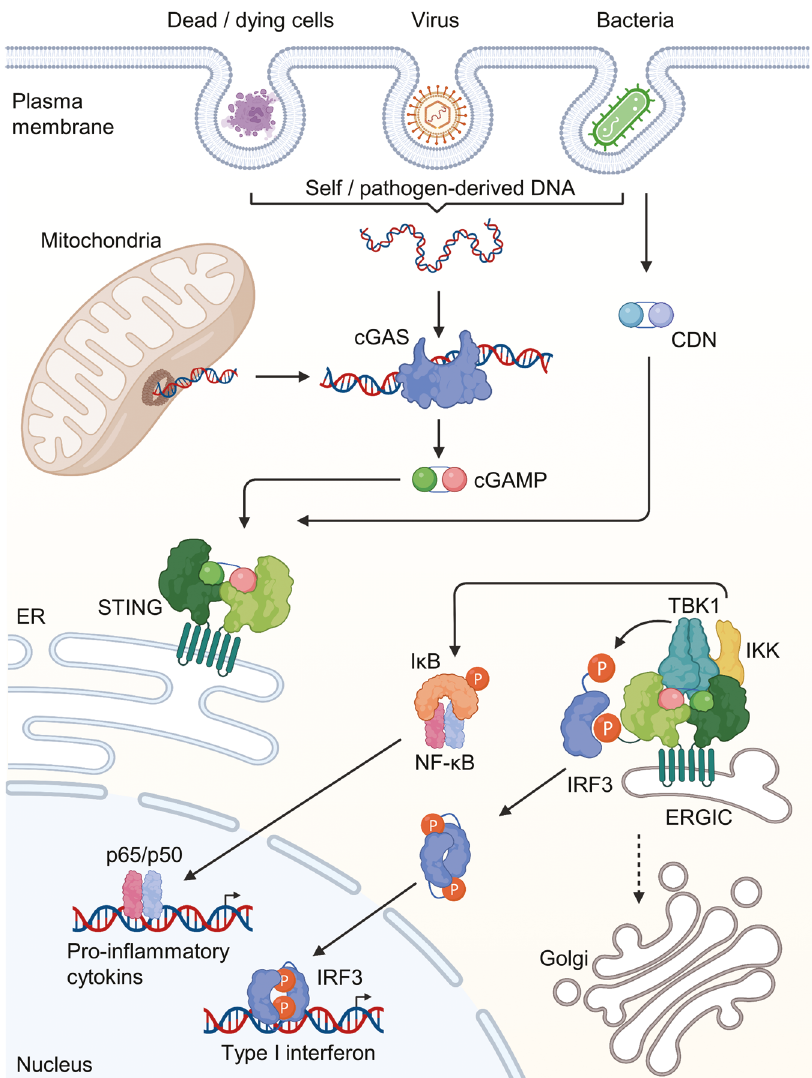
Fig. 1 Overview of the cGAS-STING signaling pathway. The host immune response is initiated by the recognition of cytosolic DNA, such as pathogen-derived nucleic acids (e.g., viruses and bacteria) and self-DNA (e.g., from dying cells, tumor cells or mtDNA). Upon recognition of cytosolic DNA, cGAS catalyzes the formation of cGAMP and thereby activates STING. STING then activates TBK1, which phosphorylates IRF3. Phosphorylated IRF3 activates the expression of type I IFNs in the nucleus. STING also activates NF- κ B by phosphorylating the kinase IKK. NF- κ B then activates the transcription of genes encoding proin fl ammatory